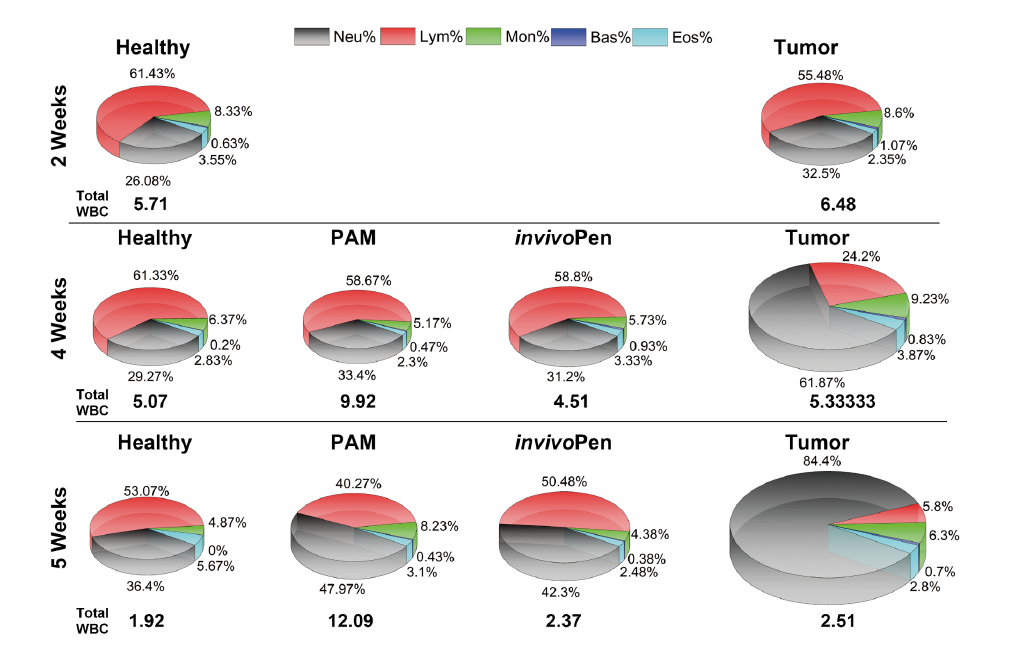
Figure 3. CAP-induced change on white blood cells. ‘Neu’, ‘Bas’, ‘Eos’, ‘Lym’, ‘Mon’, each is short for neutrophil, basophil, eosinophile, lymphocyte, and monocyte, respectively, which are measured components of white blood cells. ‘invivoPen’ and ‘PAM’ each represents direct and indirect treatment, respectively. Reproduced from [6] with permission. Copyright c (cid:13) the authors under the terms of